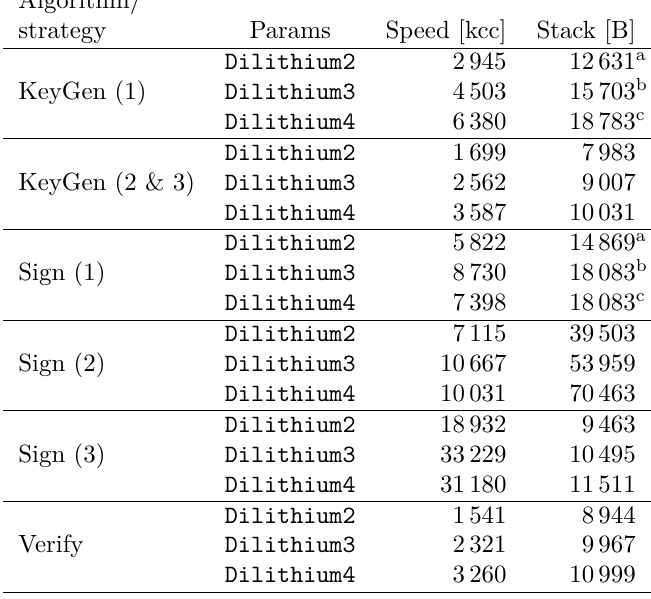
Table 4: Performance results on the Cortex-M3 (SAM3X8E at 16 MHz). Averaged over 10000